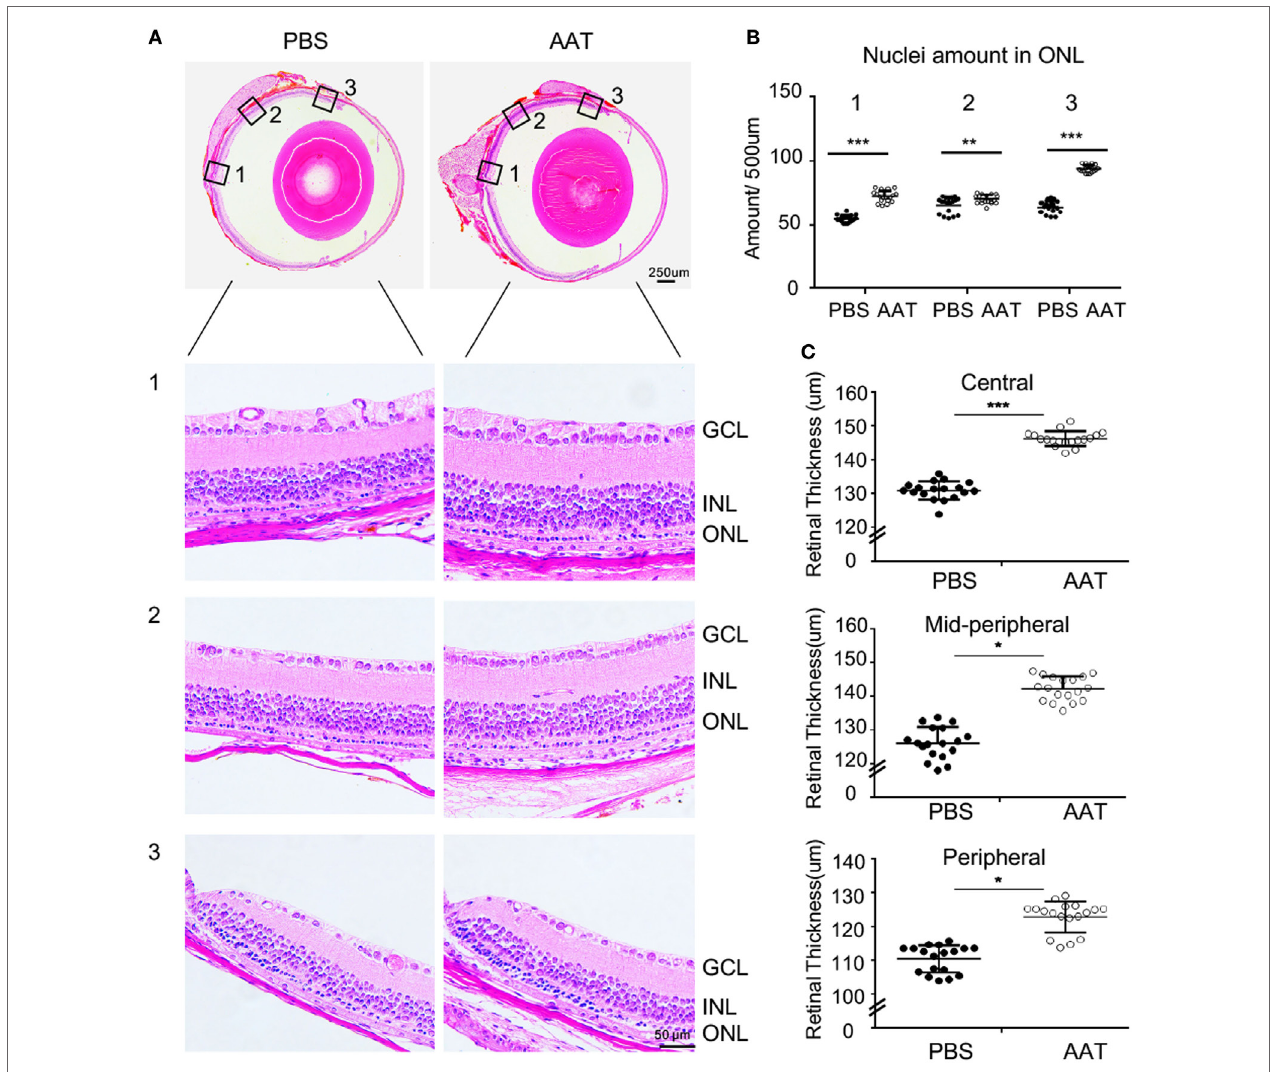
FigUre 3 | Alpha-1 antitrypsin (AAT) alleviated the decrement of retinal thickness in rd1 mice. (a) Panoramic view of the central [Location 1], mid-peripheral [Location 2], and peripheral [Location 3] areas in the retinal paraffin sections by H&E staining. The representative images showed denser nuclei in the outer nuclear layer (ONL) and thicker retinal thickness of the rd1 mice treated with AAT compared to those with PBS treatment at P16. Scare bar, 50 µm. (B) The amounts of cellular nuclei in ONL at indicated locations were elevated significantly after AAT treatment in comparison with PBS controls. (c) The total thicknesses of retina were increased in the center, mid-periphery, and periphery areas in AAT-treated rd1 mice, compared with those in PBS-treated controls. Six sections of each retina and three retina of each group were used for analysis. * p < 0.05, ** p < 0.01, *** p < 0.001 (two-tailed unpaired t